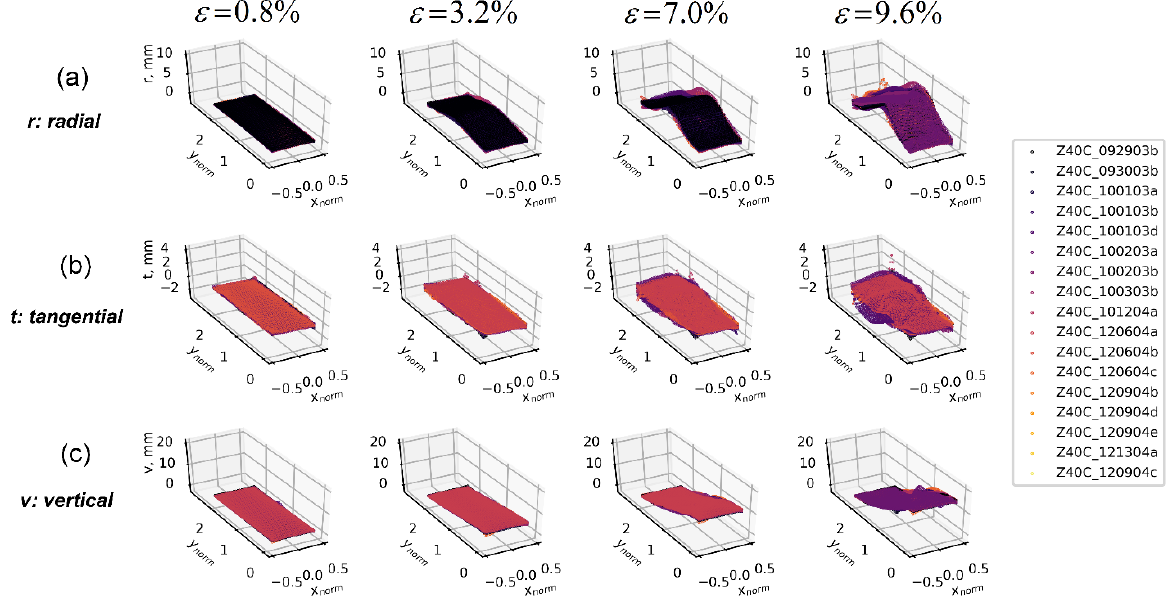
Figure 12. A 3D-T data ensemble (clouds of points) under the cylindrical coordinate system at four loading stages—0.8%, 3.2%, 7.0%, and 9.6% of axial strain. Coordinates are normalized according to the specimen’s diameter. ( a ) Radial (r) displacement data ensembles. ( b ) Tangential (t) displacement data ensembles. ( c ) Axial (v) displacement data